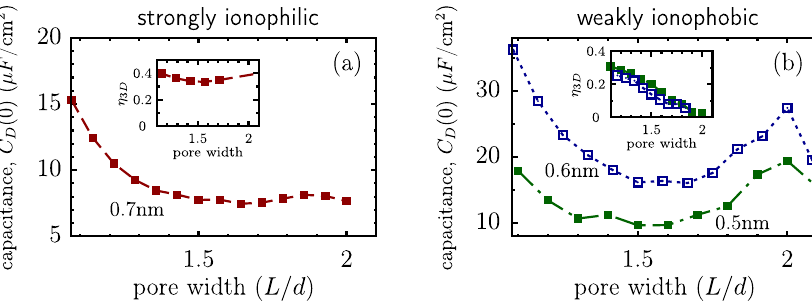
ð 0 Þ , as the pore width varies. The results of Monte Carlo D T ) and for weakly ionophobic pores ( δ E ¼ 38 . 5 k B ¼ ð π = 6 Þ ρ d 3 as a function of pore D